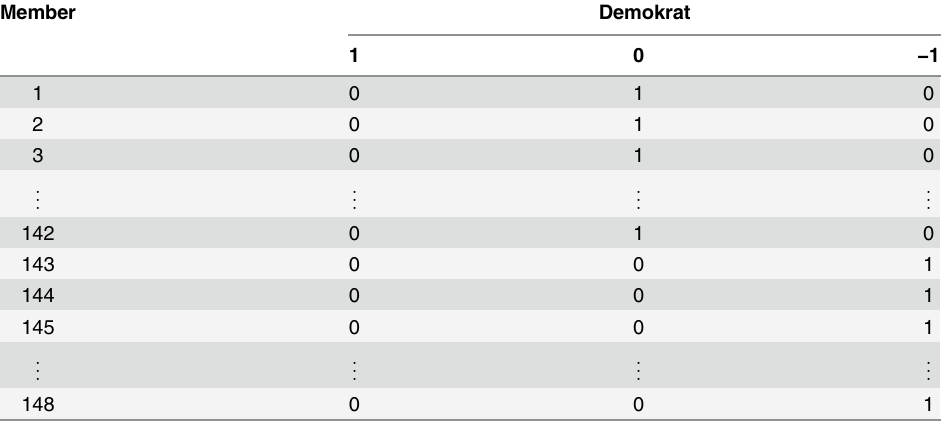
Table 11. A decomposition of Table 10 into multi-tables of Boolean-Valued for